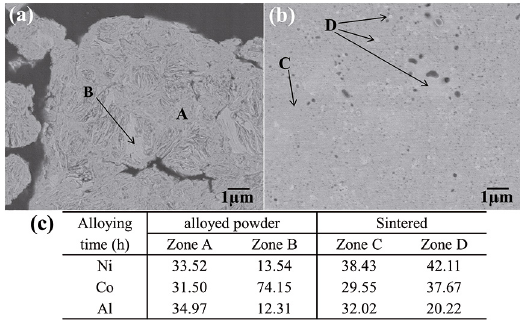
Figure 3: Backscattered electron SEM micrographs of AlCoNi samples: (a) cross-section powder with 10 h of milling and (b) sintered at 1200°C, as well as (c) EDS-SEM